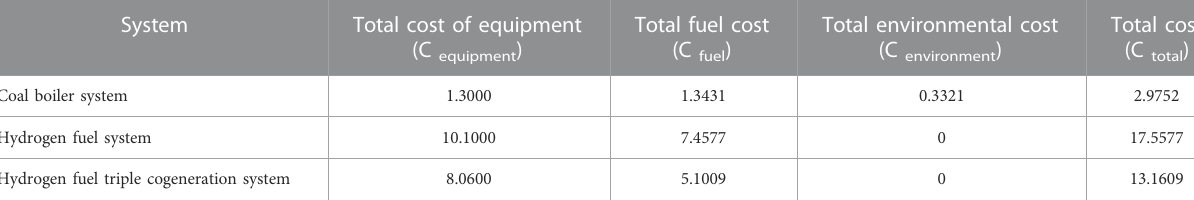
TABLE 3 Total cost of the energy systems (Unit: ten thousand